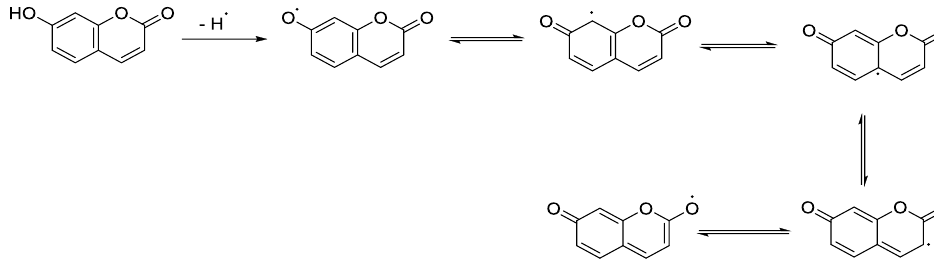
Figure 15. Resonance stability of phenoxy radical of 7- hydroxy coumarin (C 3